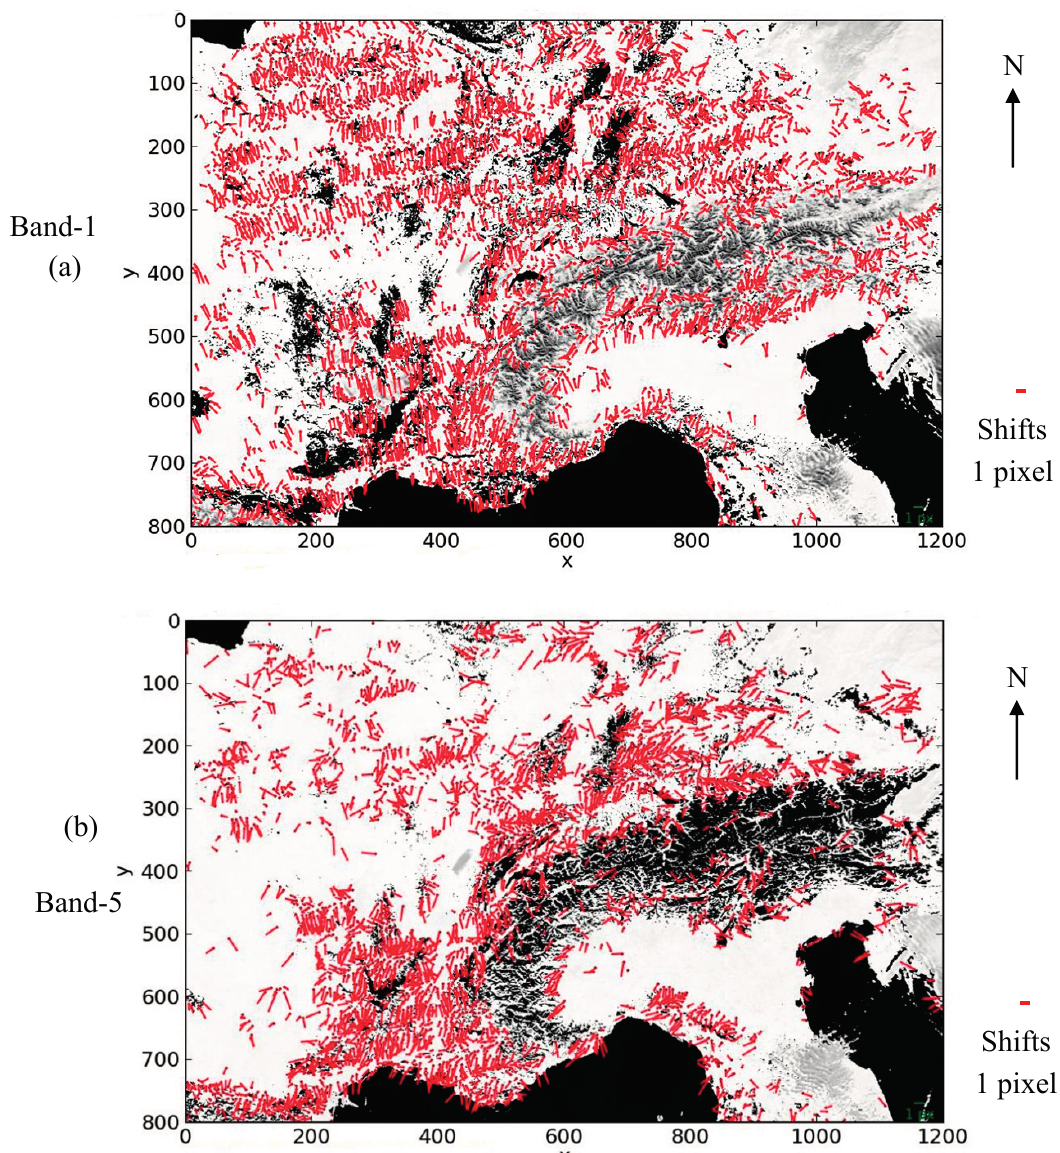
Figure 13. Image space shifts obtained from the matching of the Band-1 ( a ) and Band-5 ( b ) images acquired from NOAA-17 and NOAA-18 on February 8, 2008. The axes denote the image